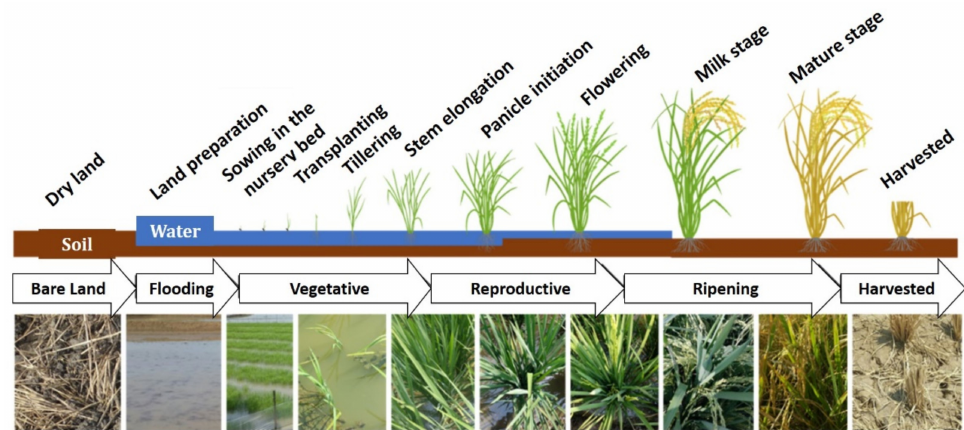
Figure 1. Paddy Rice Growth Stages Illustration from [2].